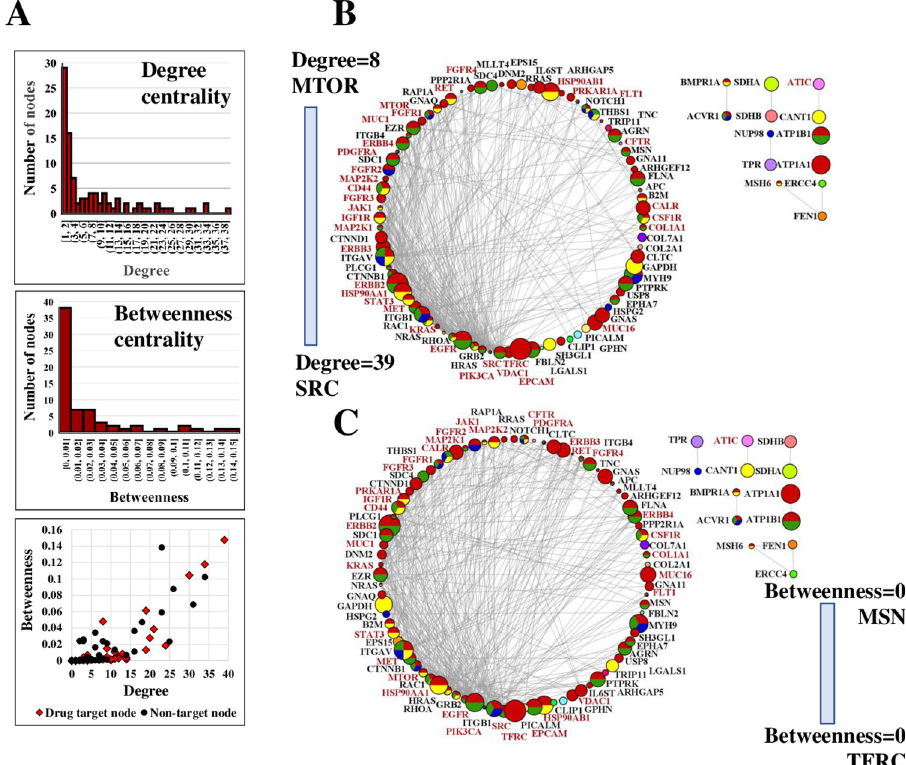
Fig 4. Network analysis of PPI networks created from 138 SKBR3 cell-membrane proteins (STRING interaction score � 0.9). ( A ) Distribution and correlation of degree and betweenness centrality measures. ( B ) Degree-based circular layout PPI network (degree = 1–39). ( C ) Betweenness-based circular layout PPI network (betweenness = 5.51E (-5)-0.15). The circular distribution of attributes is presented in a clockwise fashion, from high (left) to low (right). Node size is proportional to the protein abundance and represented as LOG10(SC) over a range of 0.301–4.214. Node color coding: red-signaling, yellow-immune response, green-locomotion, blue-angiogenesis. Gene names that represent drug targets are shown in red. Network statistics: nodes 138 (only 97 nodes with degree � 1 are shown), edges 397, avg # neighbors 9.262, network diameter 5, network radius 3, characteristic path length 2.406, clustering coefficient 0.466, network density